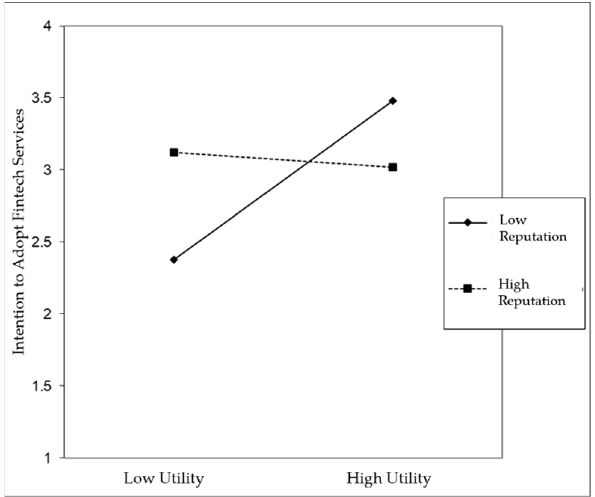
Figure 4. Interaction Perception of Reputation of Fintech Services × Perception of Usefulness of Fintech Services (Source: Microsoft Excel 365).